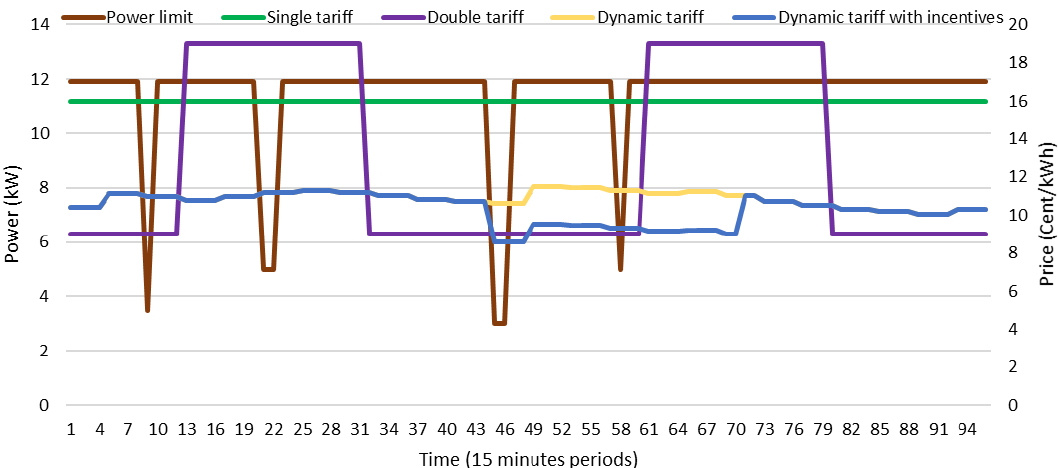
Figure 3. Power consumption limits and electricity prices in each period.